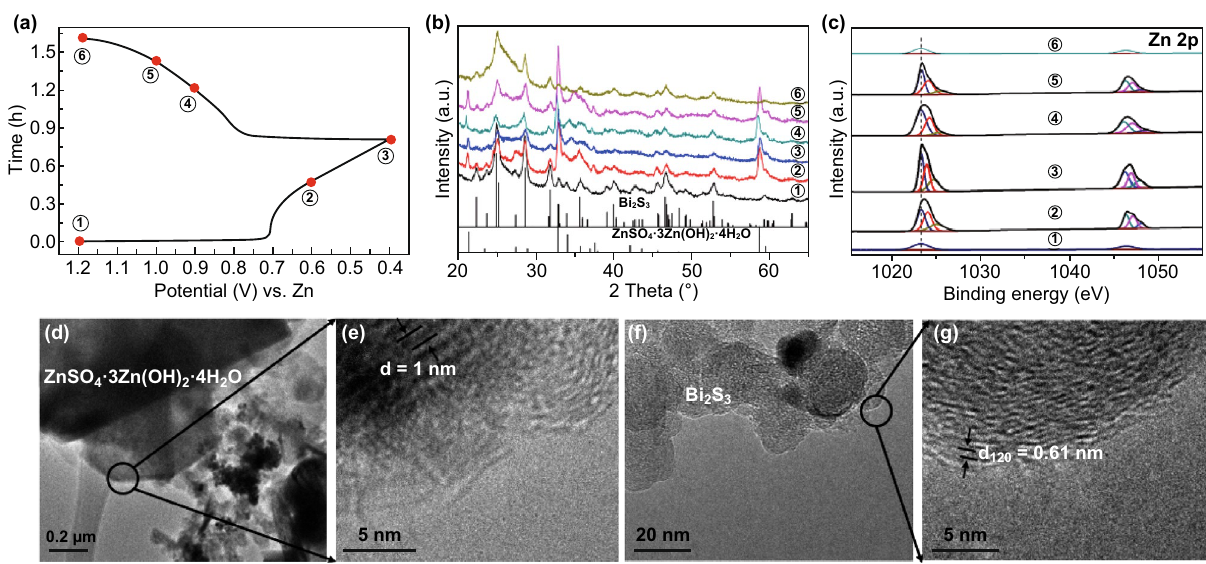
Fig. 4 a Charge/discharge curve at 0.2 A g −1 . b The corresponding ex situ XRD patterns. c XPS spectra Zn 2p at selected states. d , e TEM images of ZnSO 4 ·3Zn(OH) 2 ·4H 2 O. f , g TEM images of Bi 2 S 3 at the fully discharged